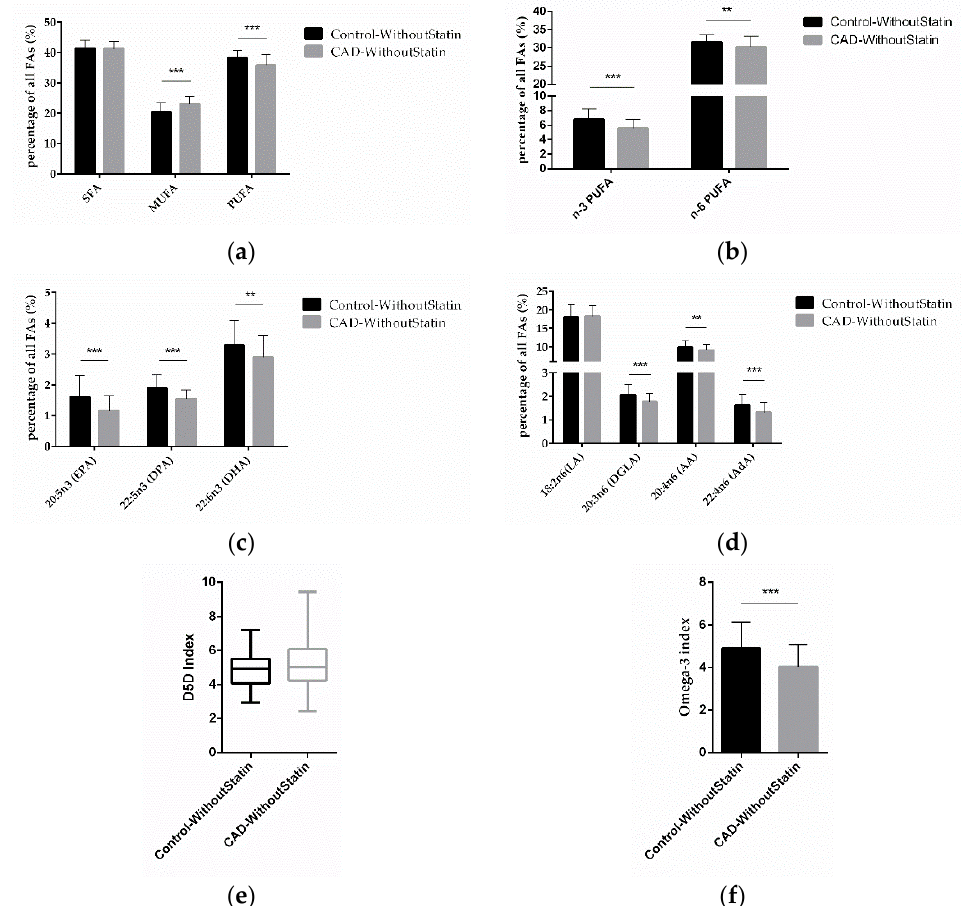
Figure 4. Correlation of FAs in control and CAD patient subgroups without statin treatment. ( a ) Relative content of SFAs, MUFAs, and PUFAs in control and CAD patients without statin treatment. ( b ) Relative content of n-3 and n-6 PUFAs in control and CAD patients without statin treatment. ( c ) Relative content of different n-3 PUFAs and ( d ) n-6 PUFAs in control and CAD patients without statin treatment. ( e ) D5D index and ( f ) omega-3 index in control and CAD patients without statin treatment. ( n = 70 for the control-without-statin group, n = 72 for the CAD-without-statin group; ** indicates 0.001 < p < 0.01, *** indicates p < 0.001).